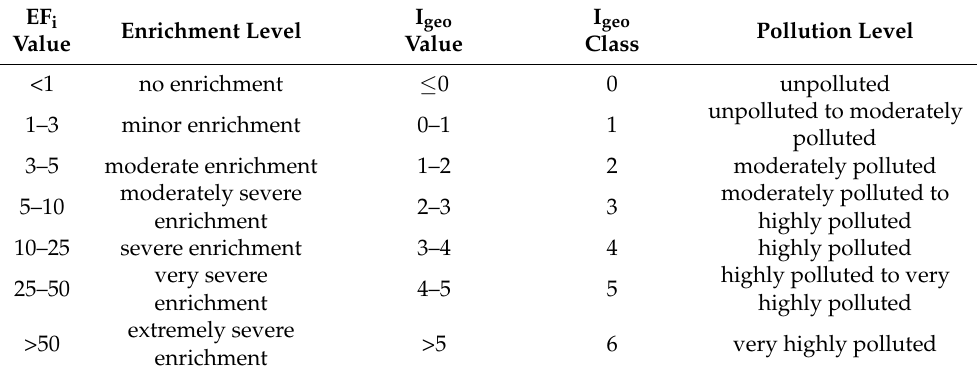
Table 2. The enrichment factor EF i and geoaccumulation index I geo .